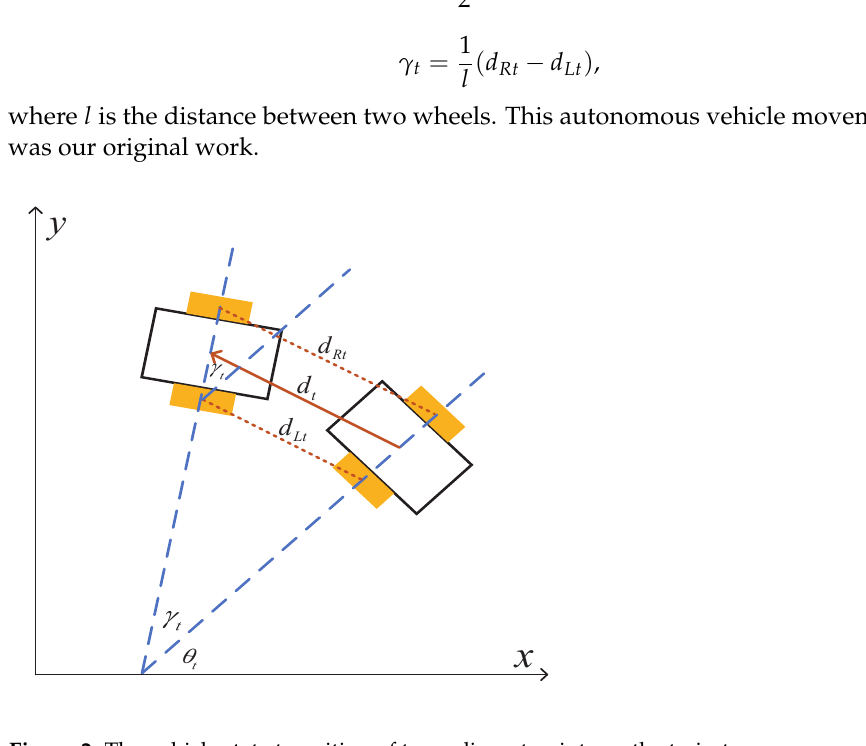
Figure 2. The vehicle state transition of two adjacent points on the